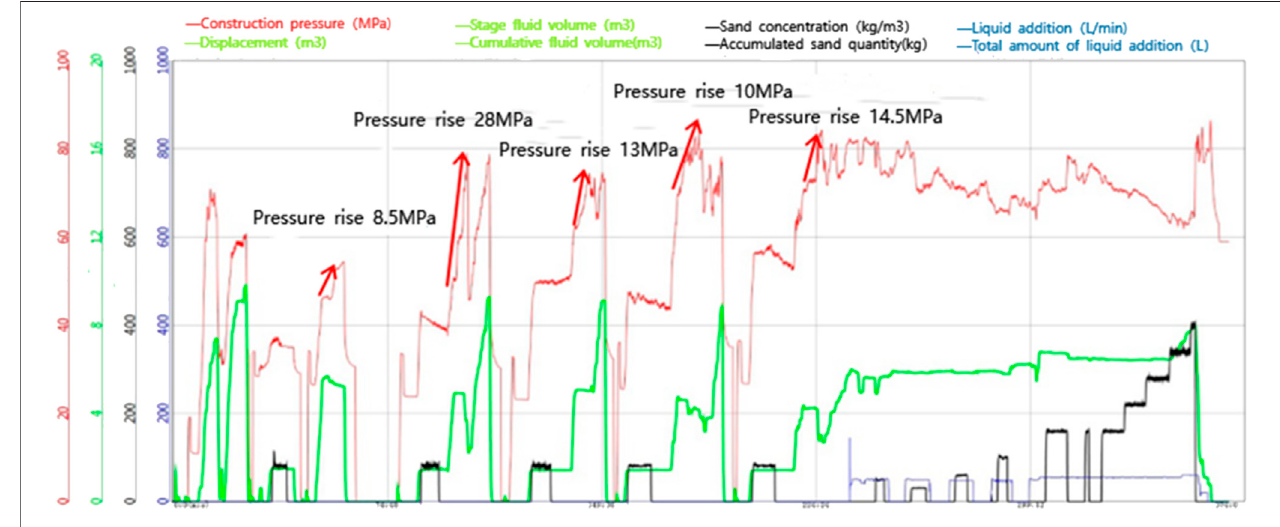
FIGURE 3 | Temporary plugging pumping curve of well M3.